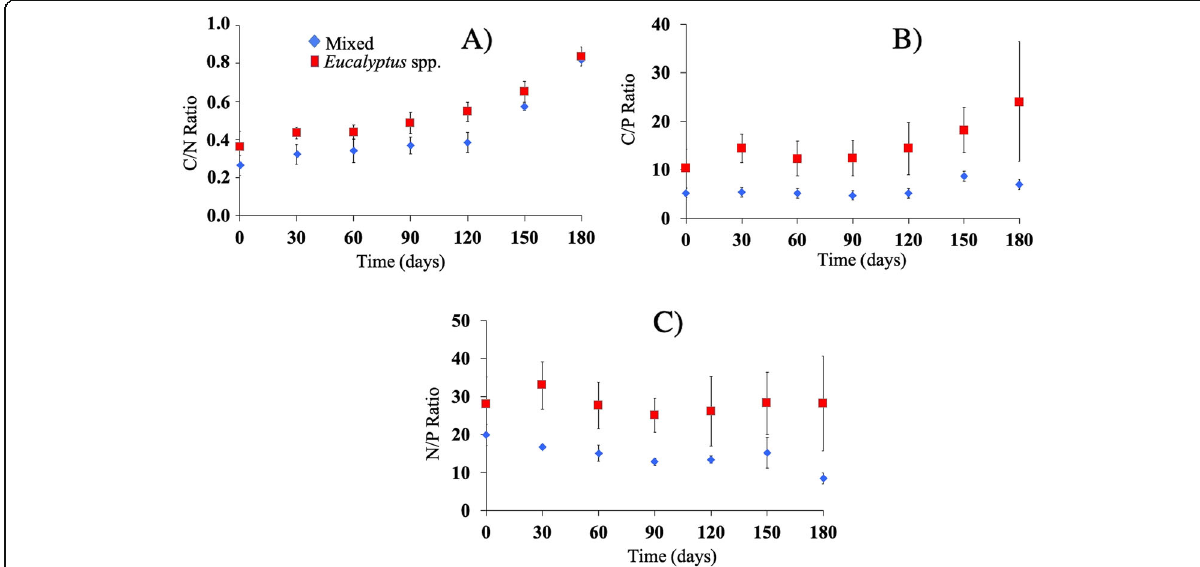
Fig. 5 Nutrient ratios of mixed and Eucalyptus spp. litter. a The C/N ratio, b C/P ratio, and c N/P ratio. Mixed litter is represented by diamonds with blue lines, and Eucalyptus spp. is represented by red squares with dotted lines